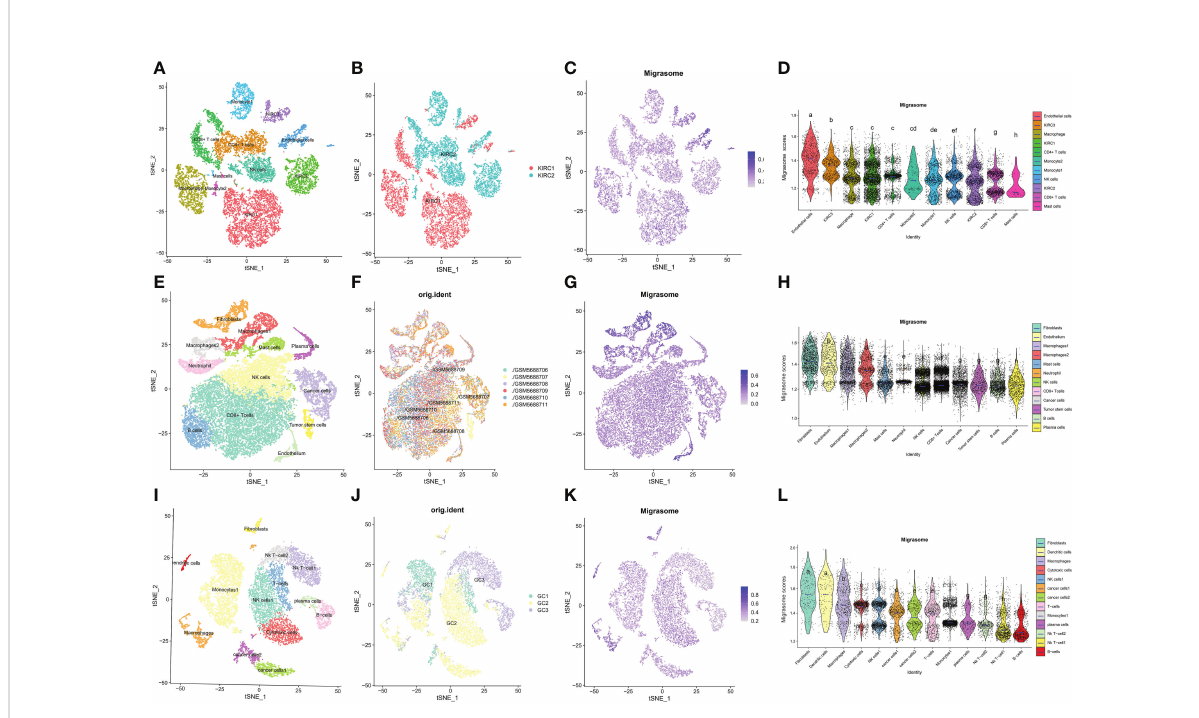
FIGURE 11 Single cell transcriptome pro fi les of kidney renal clear cell carcinoma (KIRC), colon carcinoma (COAD) and stomach adenocarcinoma (STAD). (A) tSEN plots of KIRC samples shows 11 different cell types. (B) tSEN plots of KIRC from two different samples. (C) tSEN plots of migrasome fractions represent different cell types. (D) Comparison of migrasome scores in different KIRC tumor microenvironment cells. The blue horizontal lines on the graphs indicate the median migrasome scores. The letter at the top indicates whether there is a statistical difference between the two comparisons between cells. A different letter indicates that the difference is statistically signi fi cant. (E) tSEN plot of COAD samples shows 12 different cell types. (F) tSEN plots of COAD for six different samples. (G) tSEN plots represent the migrasome fraction of different cell types. (H) Comparison of migrasome scores in different COAD tumor microenvironment cells. The blue horizontal lines on the graphs indicate the median migrasome scores. The letter at the top indicates whether there is a statistical difference between the two comparisons between cells. A different letter indicates that the difference is statistically signi fi cant. (I) tSEN plot of STAD samples shows 13 different cell types. (J) tSEN plots of STAD for three different samples. (K) tSEN plots represent the migrasome fractions of different cell types. (L) Comparison of migrasome scores in different STAD tumor microenvironment cells. The blue horizontal lines on the graphs indicate the median migrasome scores. The letter at the top indicates whether there is a statistical difference between the two comparisons between cells. A different letter indicates that the difference is statistically signi fi